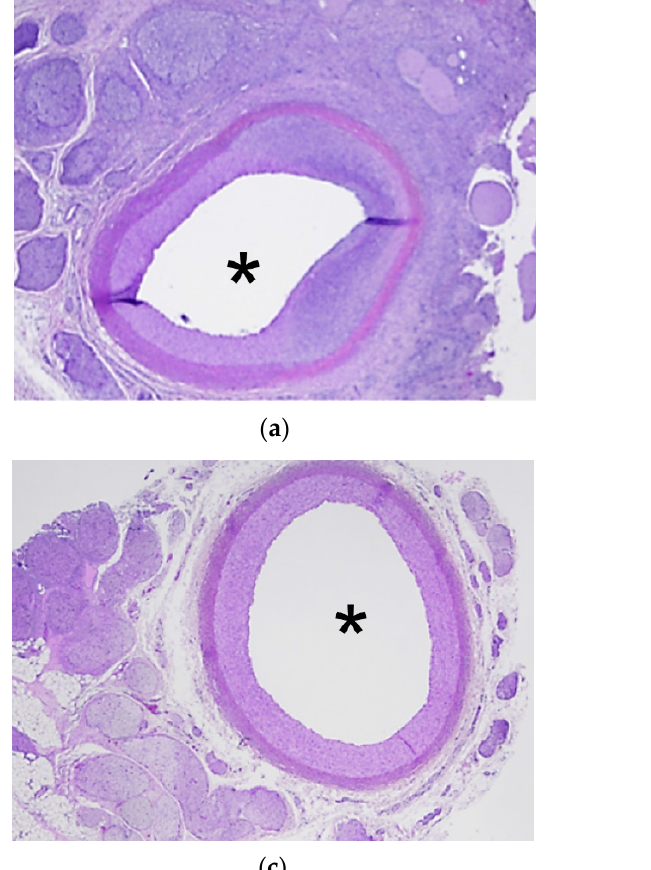
Figure 7. Histological examination of a typical example of the treated plexus nerve (location indi- cated by *) around the treated arteries. Hematoxylin and eosin stain; magnification ×200. 4. Discussion This study was designed to confirm the feasibility, safety, and efficacy of the in- traoperative HIFU ablation of pancreatic parenchyma surrounding the superior mesen- teric vessels using the same HIFU device used in humans for the treatment of liver metas- tases [18]. Treatments with energy escalation under Doppler guidance allowed for the de- termination of sonication parameters to create a safe thermal ablation procedure at least 18 mm in size in all directions without occlusion of the peripancreatic hepatic artery. HIFU treatments were performed in 15 min. This study also identified the treatment parameters that can induce temporary arterial occlusion. Once a temporary arterial spasm has been generated, sonication can be performed without creating any additional spasm of the ar- tery. This is due to the lesioning of nerve bundles in the periphery of the artery, and no secondary thromboses due to the lesioning of the endothelium of the arteries were ob- served for up to 14 days. Moreover, we previously demonstrated that HIFU thermal ab- lation in the pancreas was well tolerated even when pseudocysts were created at the treated site [24]. With a delivered energy of 30 kJ, eight reproducible HIFU thermal abla- tions were generated in the pancreas and around the peripancreatic hepatic artery without